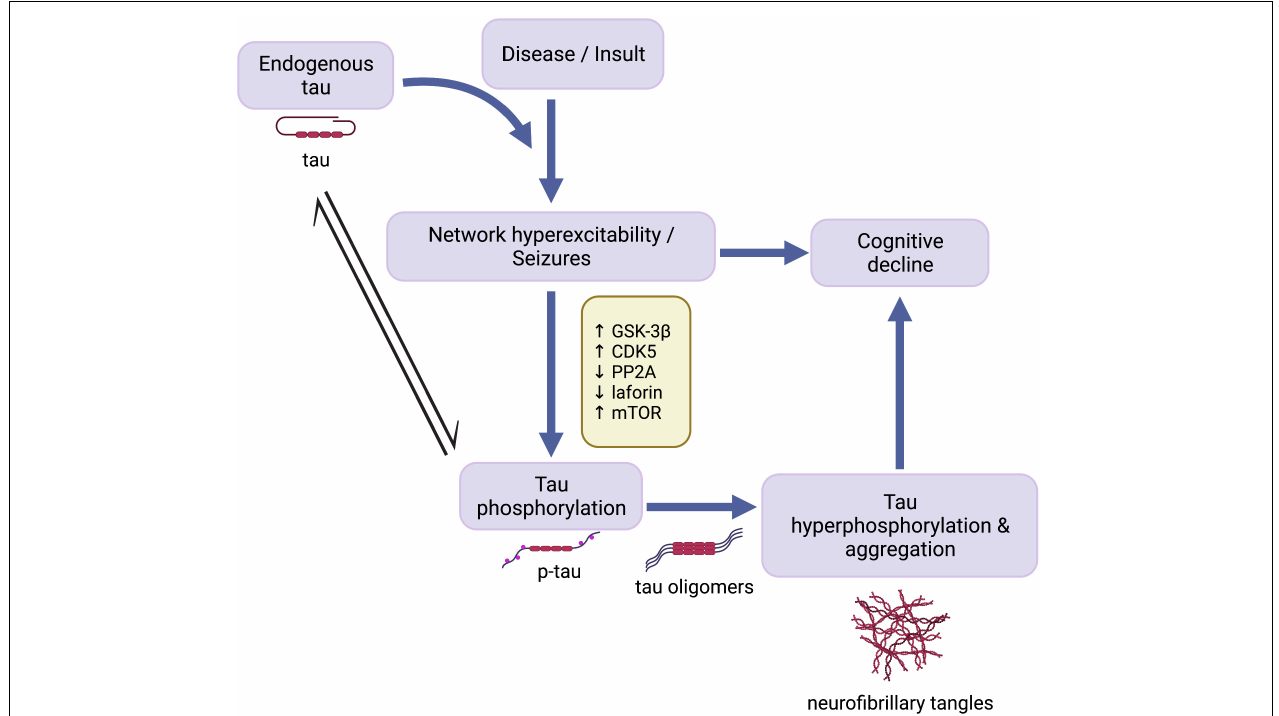
FIGURE 1 | Cascade of events in development of seizures and tau pathology. Endogenous tau has an enabling function in the development of seizure activity following disease onset or traumatic insult. Network hyperexcitability in turn leads to cognitive decline and the activation of mechanisms involving mTOR and tau kinases and phosphatases, resulting in abnormal phosphorylation of tau. Overactivation of these cell signaling pathways increases susceptibility to pathological tau hyperphosphorylation and aggregation, which may also contribute to epilepsy-associated cognitive decline. GSK-3 β , glycogen synthase kinase-3 β ; CDK5, cyclin-dependent kinase 5; PP2A, protein phosphatase 2A; mTOR, mammalian target of rapamycin; p-tau, abnormally phosphorylated tau. Created with